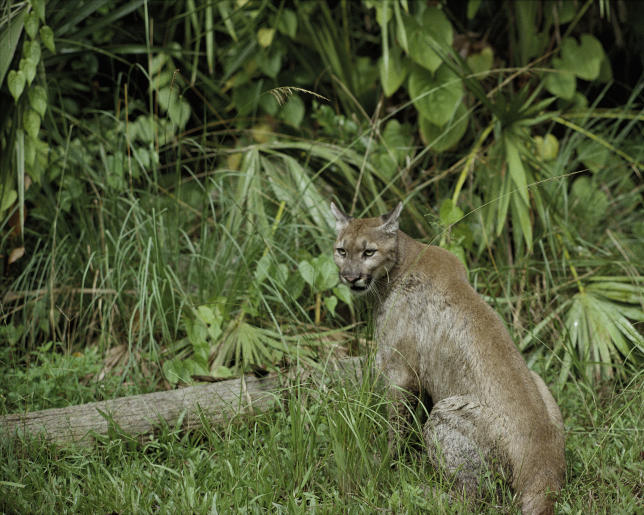
The Florida Panther National Wildlife Refuge Harbors One of the Rarest Animals in the WorldJust 80 Florida panthers remain in the wild—up from 30–50 animals in 1995. This critically endangered, wide-ranging carnivore faces the same problem that places endangered species at risk worldwide: fragmented, degraded, and vanishing habitat. Florida paves over 450 acres of green space a day, forcing panthers onto deadly roads and triggering often-fatal territorial battles over smaller and smaller ranges.(Photo: US Fish and Wildlife Service)